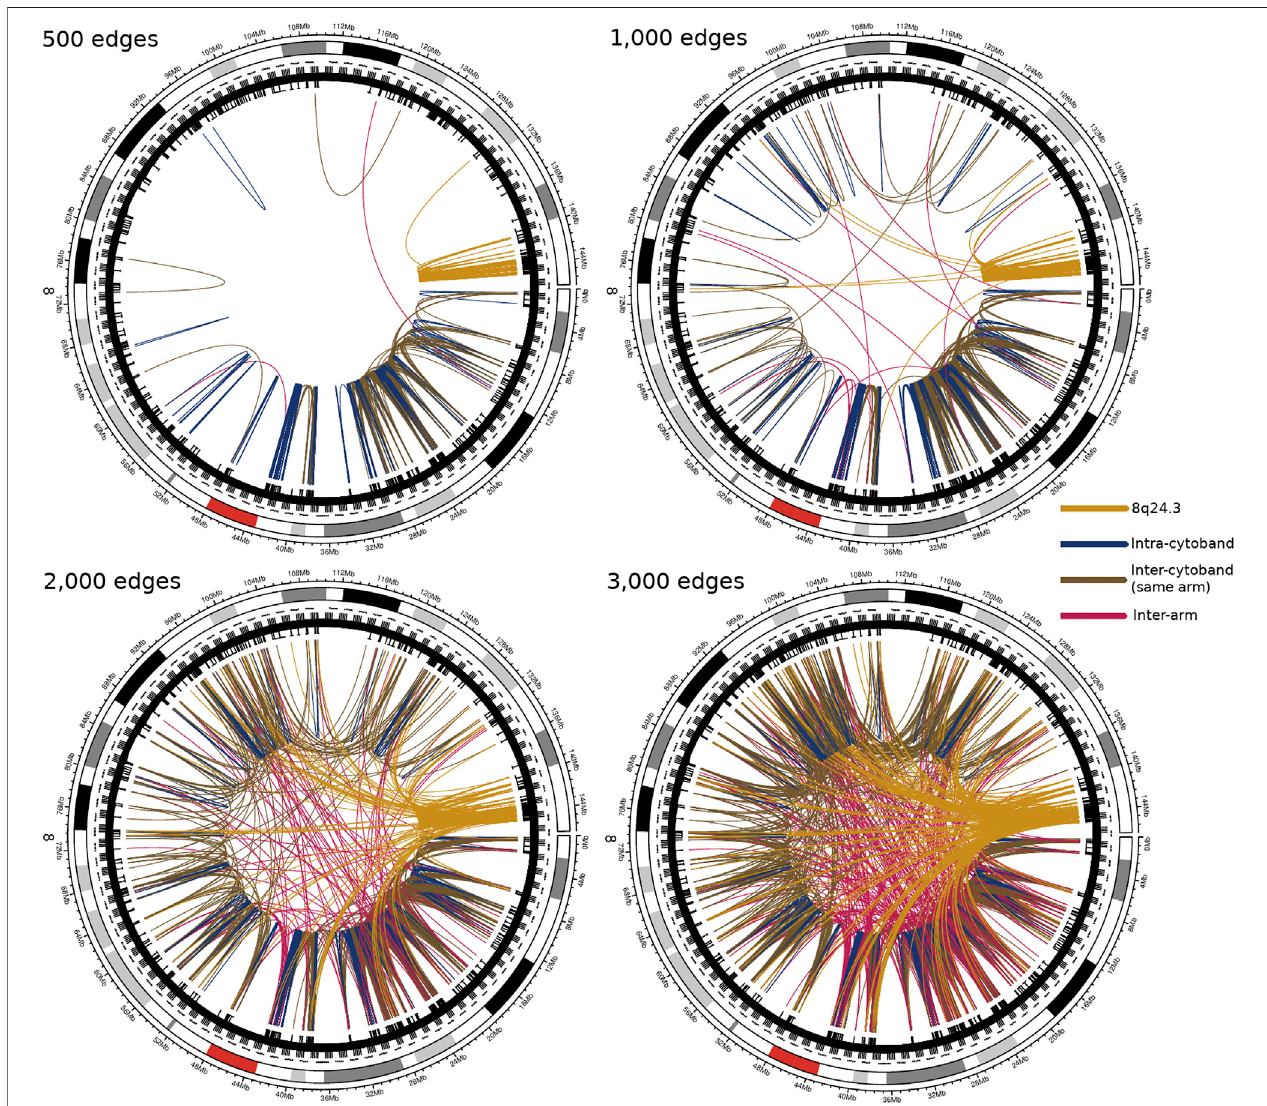
FIGURE4| TopinteractionsofLuminalBCMInetworkatdifferentcut-offs(500,1,000,2,000,and3,000edges).At fi rst,theintra-cytobandinteractionsdominate, mainlyinq24.3,p21.3,p11.21andp11.23;secondly,theinter-cytobandinteractions(particularlyinp-arm),and fi nally,theinter-armedges.Redarcattheexternalcircle representsthecentromereofChr8.Colorcodeoftheco-expressioninteractionsarealsodescribed.Thetake-homemessageisthatforthetopinteractions,thelocation of participating genes is very close between them, in particular, at cytoband q24.3.